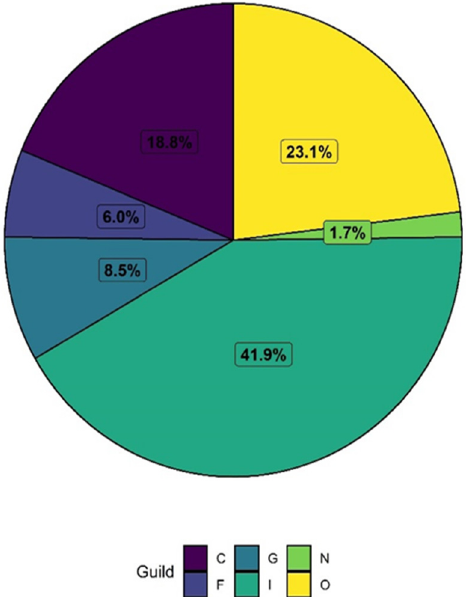
Figure 8. The pie chart represents the occurrence of birds feeding guild richness (%) in the study area; C = Carnivore, F = Frugivore, G = Granivore, I = Insectvore, N = Nectarivore, and O = Omnivore.